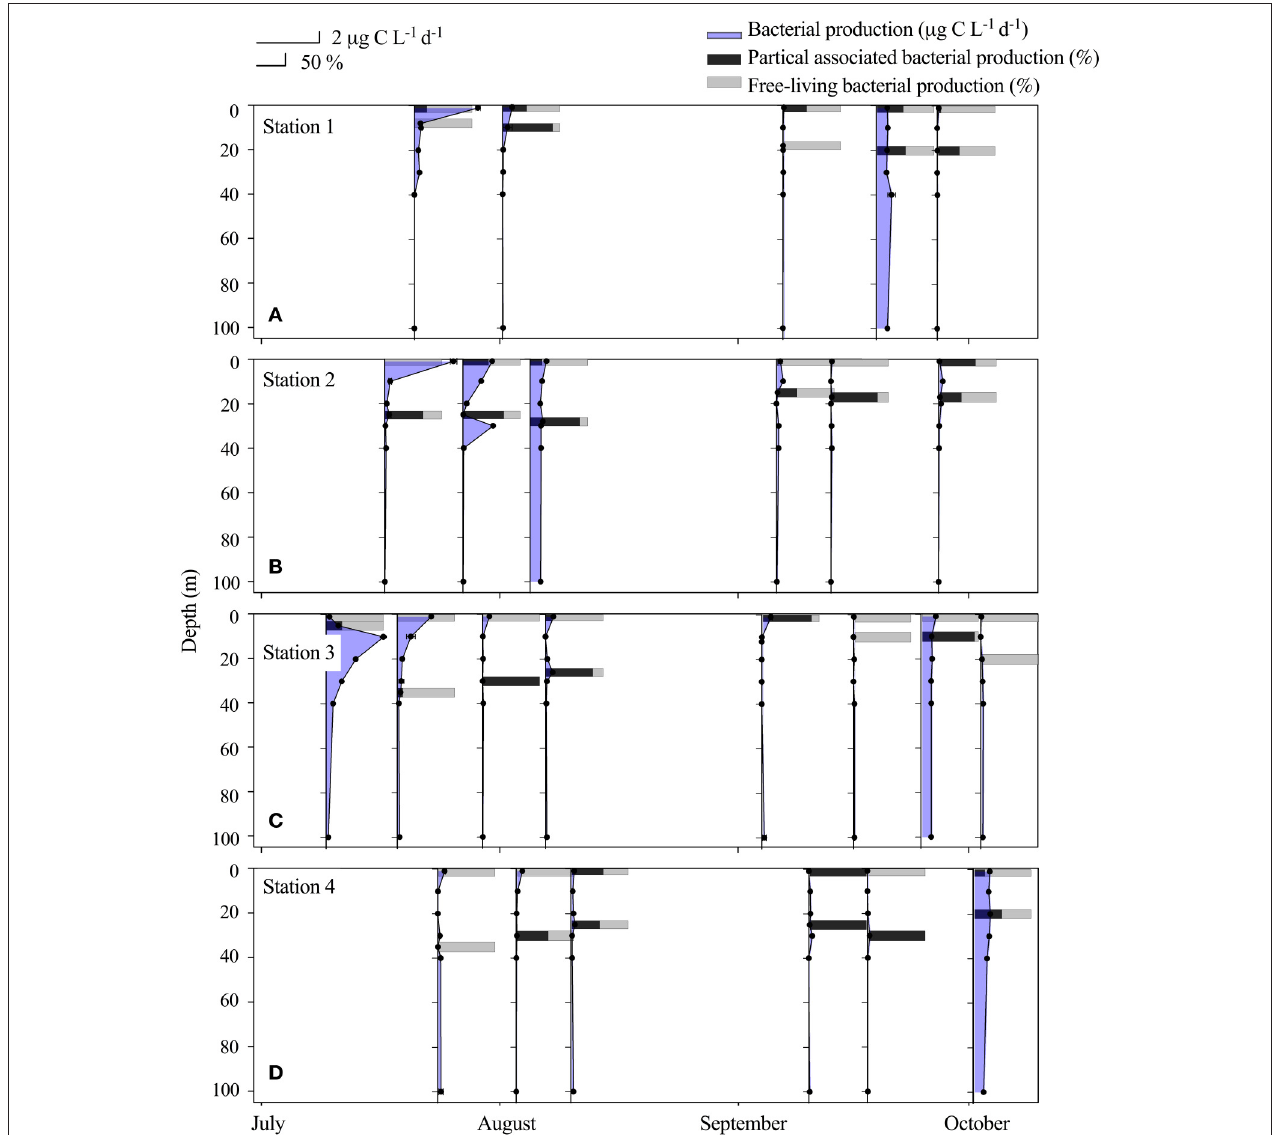
FIGURE 4 | Vertical distribution (upper 100 m) at Station 1 (A) , Station 2 (B) , Station 3 (C) and Station 4 (D) of bacterial production ± SD, n = 3 ( µ g C L − 1 d − 1 ). The horizontal bars indicate the relative distribution between particle-associated bacterial production and free-living production (%) at 1m and at the deep chlorophyll max (DCM) from July to October at the 4